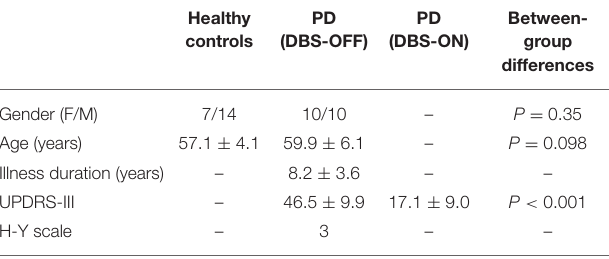
TABLE 1 | Demographics and clinical